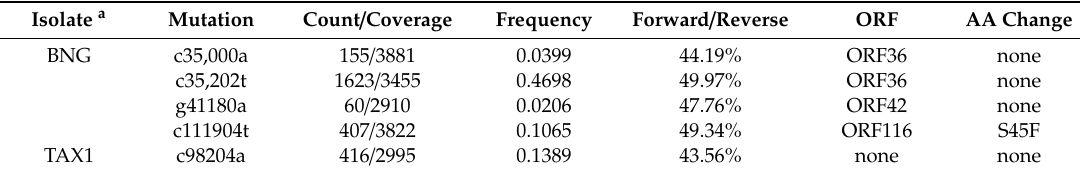
Table 4. Within-isolate